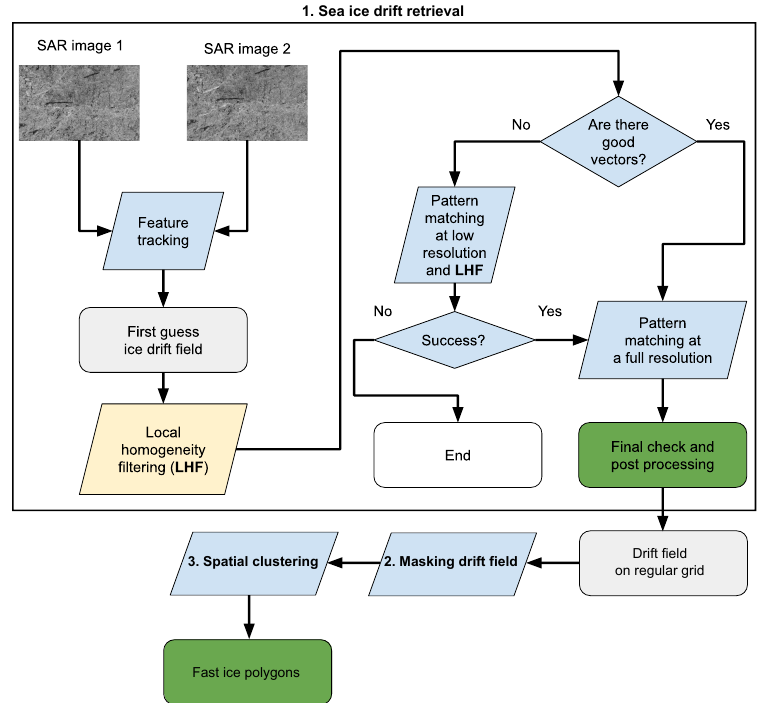
Figure 1. Flowchart of the fast ice detection